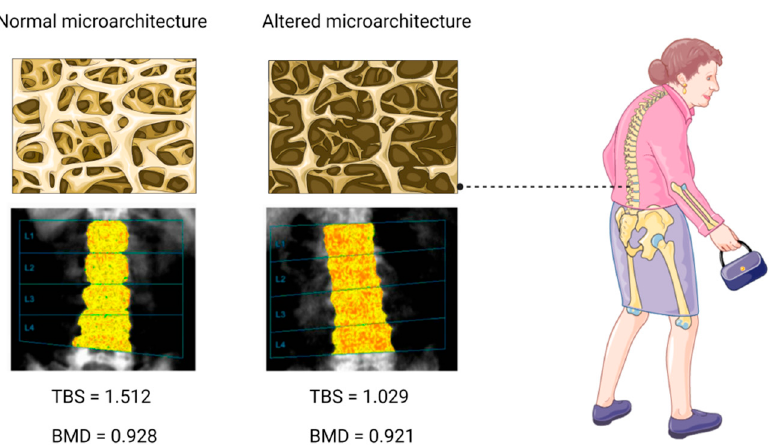
Figure 2. Trabecular bone score (TBS) as a useful technology for the assessment of the trabecular microarchitecture. TBS > 1.31 ( left ) denotes a normal microarchitecture, whereas TBS < 1.23 ( right ) indicates an altered microarchitecture. TBS can detect differences between similar values of lumbar spine bone mineral density (BMD) estimated by dual-energy X-ray absorptiometry (DXA) (g/cm 2 ).